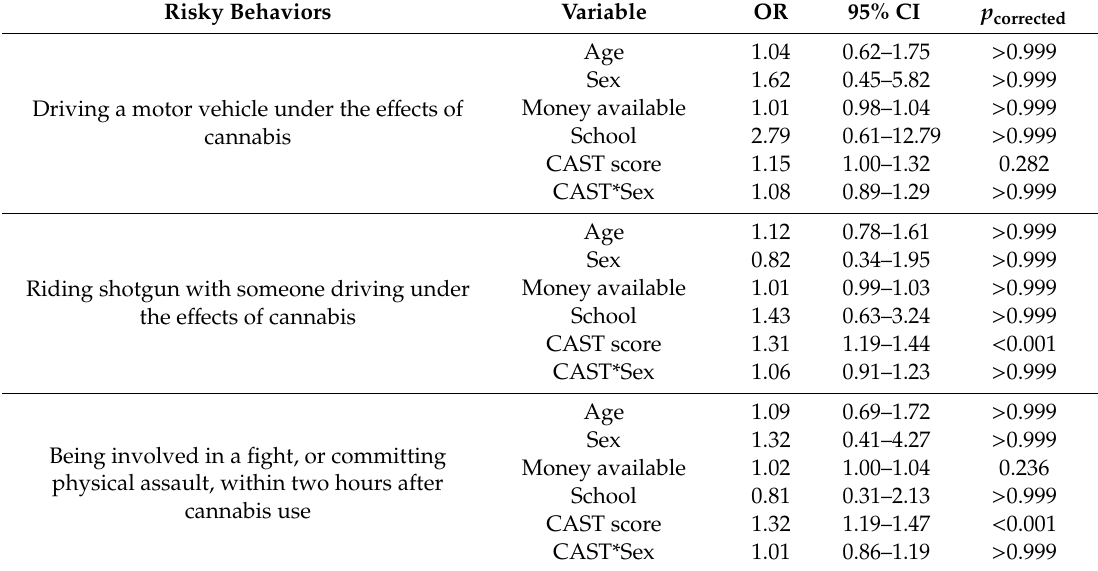
Table 4. Logistic regressions for risky